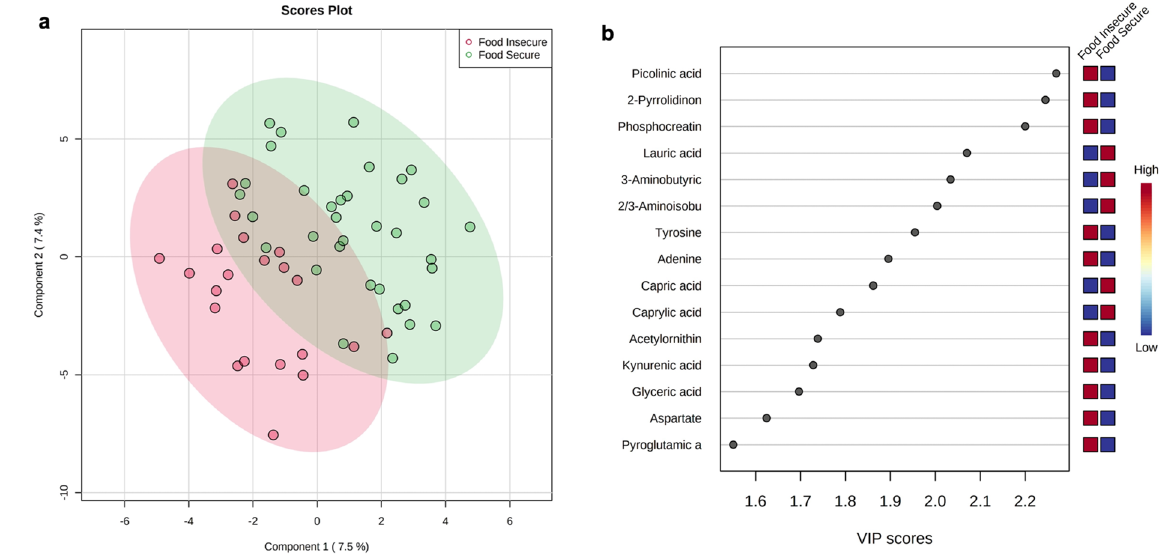
Figure 5. Partial least squares-discriminant analysis (PLS-DA) and variable importance in projection (VIP) analysis of food secure and food insecure groups using all detected metabolites in the study. ( a ) Two- dimensional scores plot of PLS-DA ( R 2 X = 0.533, R 2 Y = 0.387, Q 2 = − 0.340). ( b ) VIP scores of modeled metabolites between groups; top 15 metabolites are shown.